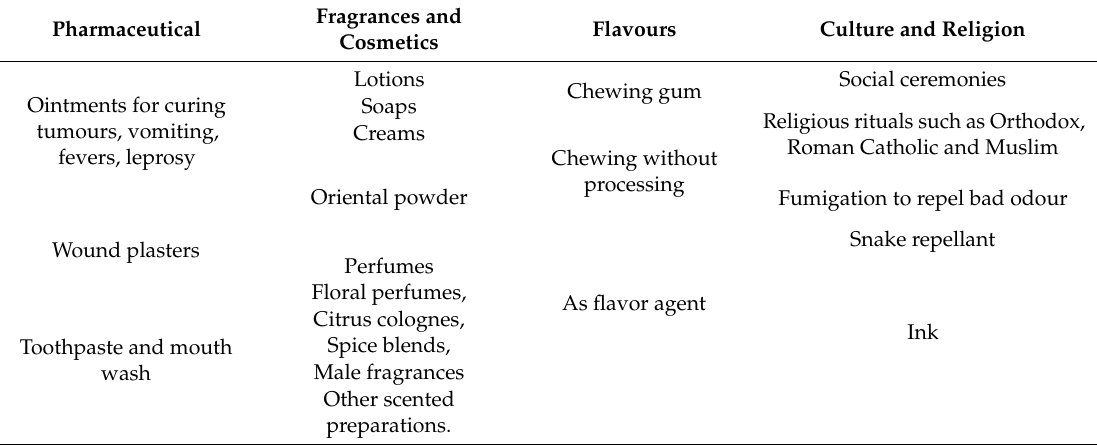
Table 3. The end-uses of frankincense and myrrh in local and international markets (modified from